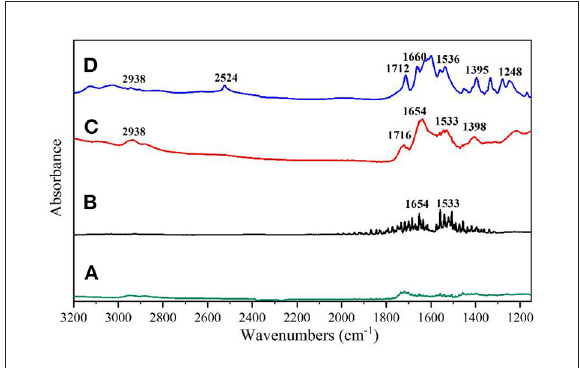
FIGURE4 (A) AgNPs; (B) 0.5 mg/mL glutathione solution; (C) 0.03 mg/mL glutathione solution mixed with AgNPs; (D) Infrared spectrum of glutathione solid potassium bromide pressed